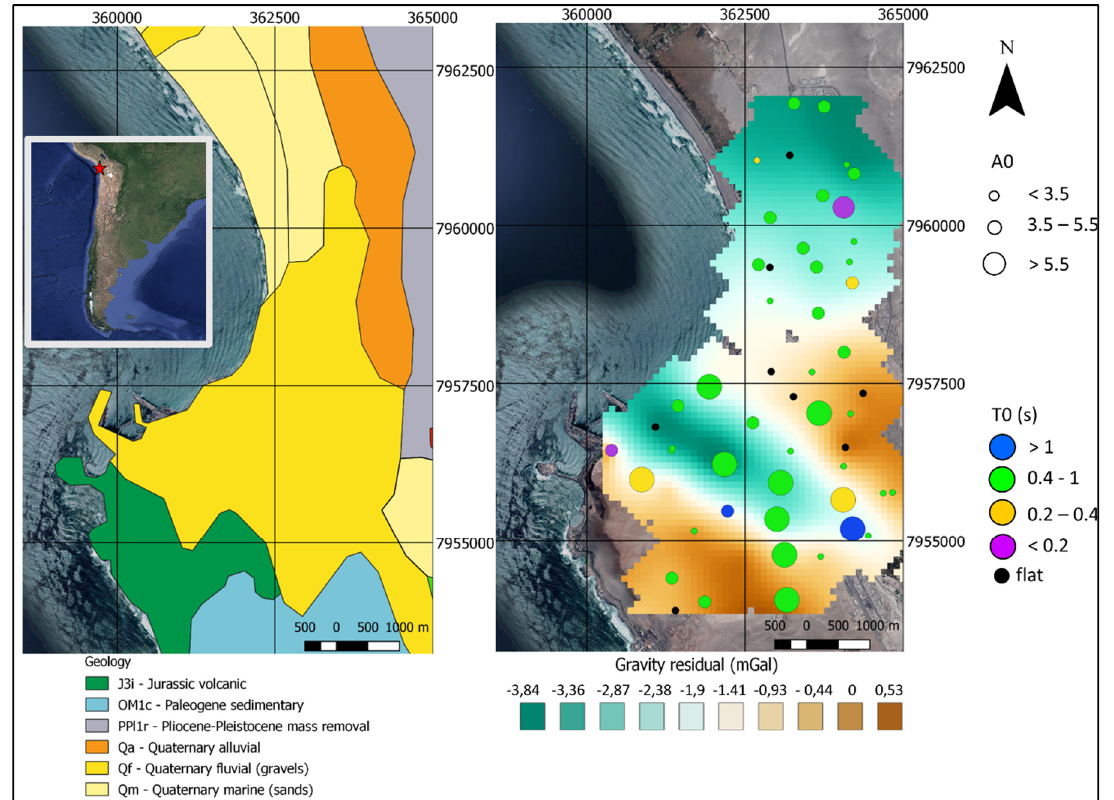
Figure 2. Arica. Left panel: Simplified geology of the city adapted from Chilean geological map 1:1,000,000 [36]. Right panel: Main results of the geophysical campaign [14,39]. The color grid shows the gravity residuals in mGal. The color points show the H/V results. Color indicates the predominant period (T0) in seconds and the size indicates the amplitude (A0) of the H/V curve.